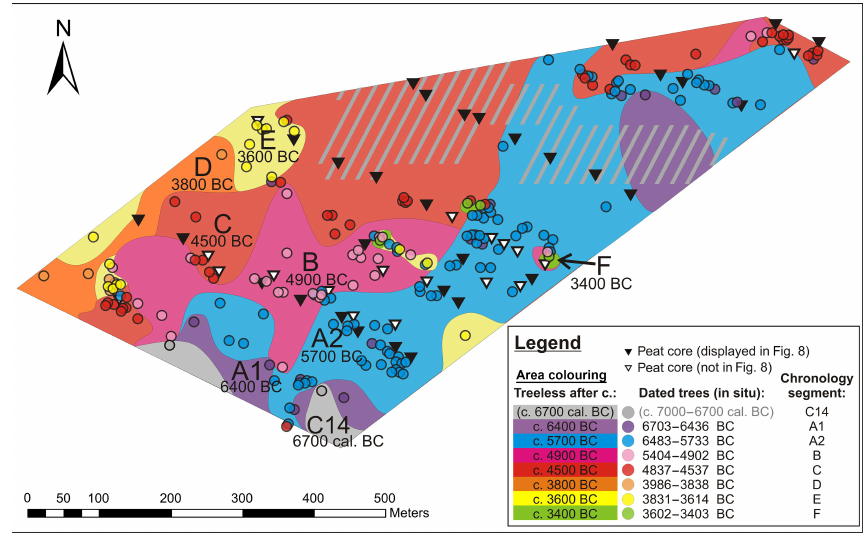
Figure 5. Reconstructed raised bog advance in terms of “no more tree growth”. The coloured dots indicate in situ tree remains, while their colour indicates the chronology segments they belong to. The hachures indicate areas with a lack of dated in situ samples. The coloured areas show where no more trees grew at a certain period. In this sense, the oldest section is where only trees of the floating, radiocarbon-dated segment C14 (beginning of the 7th millennium cal BC) were found, which is coloured grey. The dark violet areas show where no trees younger than the first group of trees with dendrochronological calendar dates, A1 (early 7th millennium BC), were found. Blue areas feature only trees from the late 7th and early 6th millennium BC (A2) and older. The pink area delivered trees from the second half of the 6th millennium BC and the beginning of the 5th (B). The red area shows where no trees grew after the first half of the 5th millennium BC (C). The orange indicates where, after that, only trees from 4000–3800BC (D) were found. The yellow area still featured trees in the first half of the 4th millennium BC (E), and the green in the second half of the 4th millennium BC (F). The colours with the corresponding dates are given to the right.